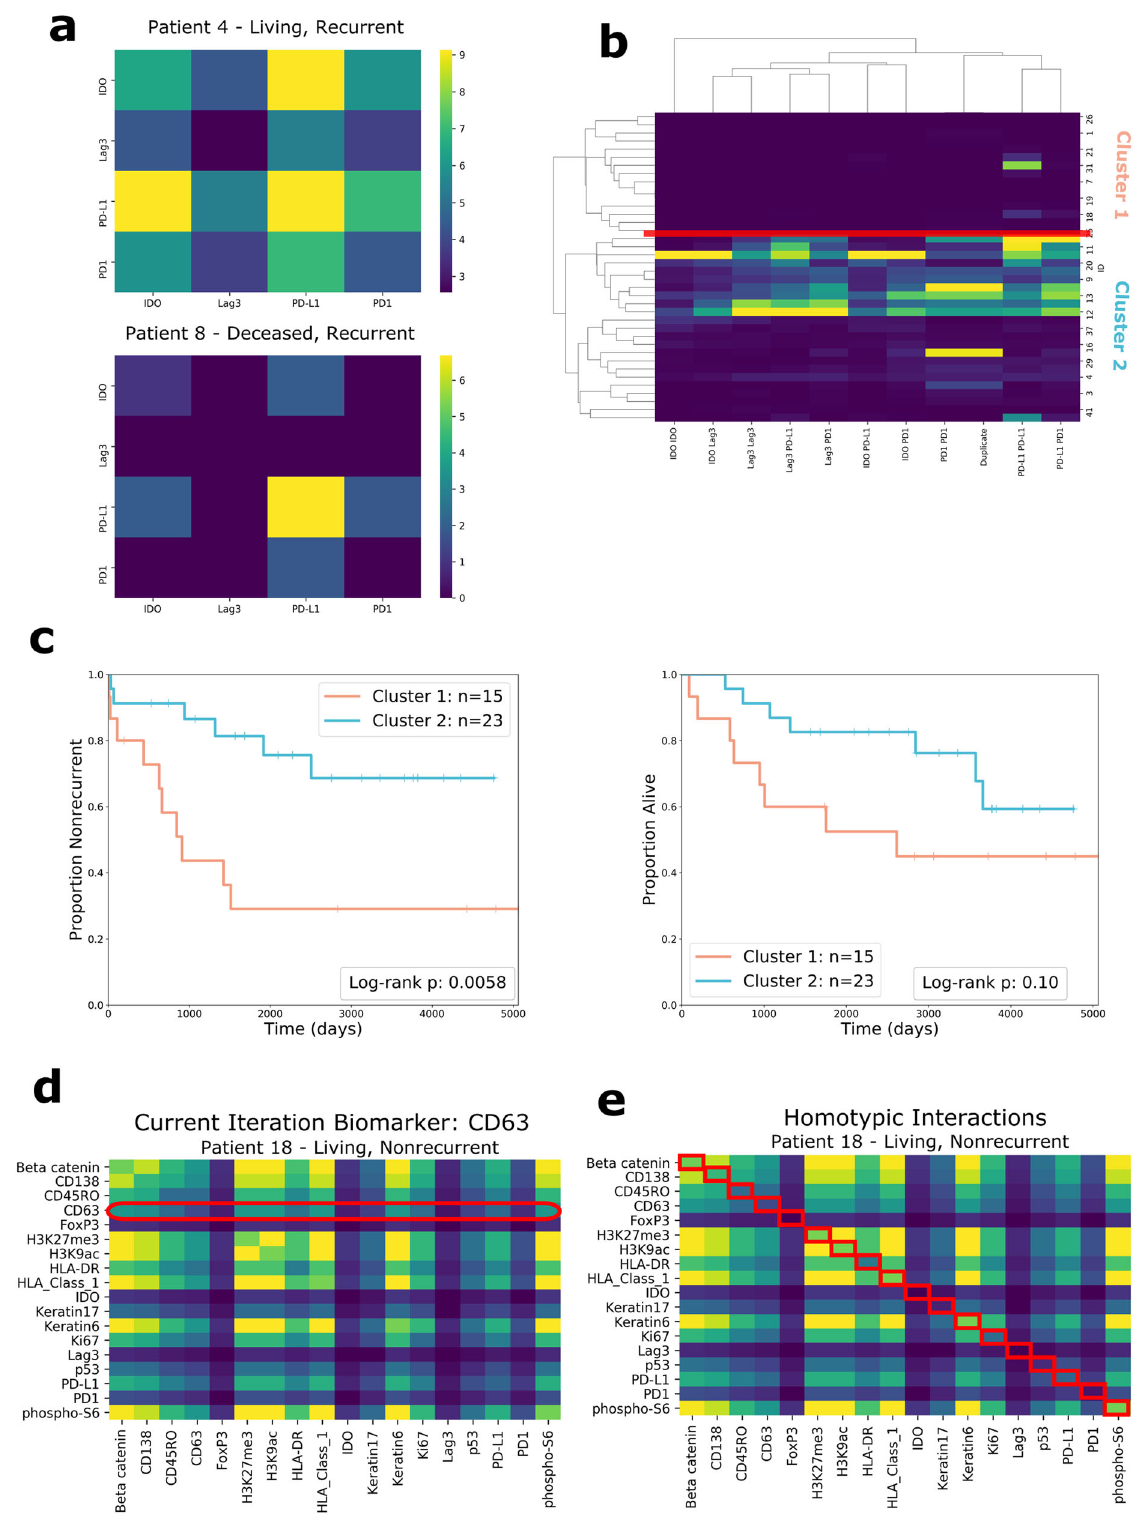
Fig. 4 Analysis of subsets of interactions. a Heatmaps of the interaction matrices of immunoregulatory proteins (IDO, Lag3, PD-L1, PD-1) for two patients, whose outcomes are shown above the heatmaps. b Clustermap of patient ’ s immunoregulatory protein interaction features. The place at which the dendrogram was split is indicated with a red line. c Kaplan – Meier curves for recurrence and survival comparing clusters formed from immunoregulatory protein interactions. Two-sided log-rank test (df = 1) p -values are shown in the plot legends. d Diagram showing how the interactions of individual proteins are evaluated through ablation analysis one at a time. The only interactions included as features are the ones that involve a speci fi c protein. The diagram gives the example of CD63. e Diagram showing the set of homotypic interactions. As shown by the red boxes, only the entries in the diagonal are included as